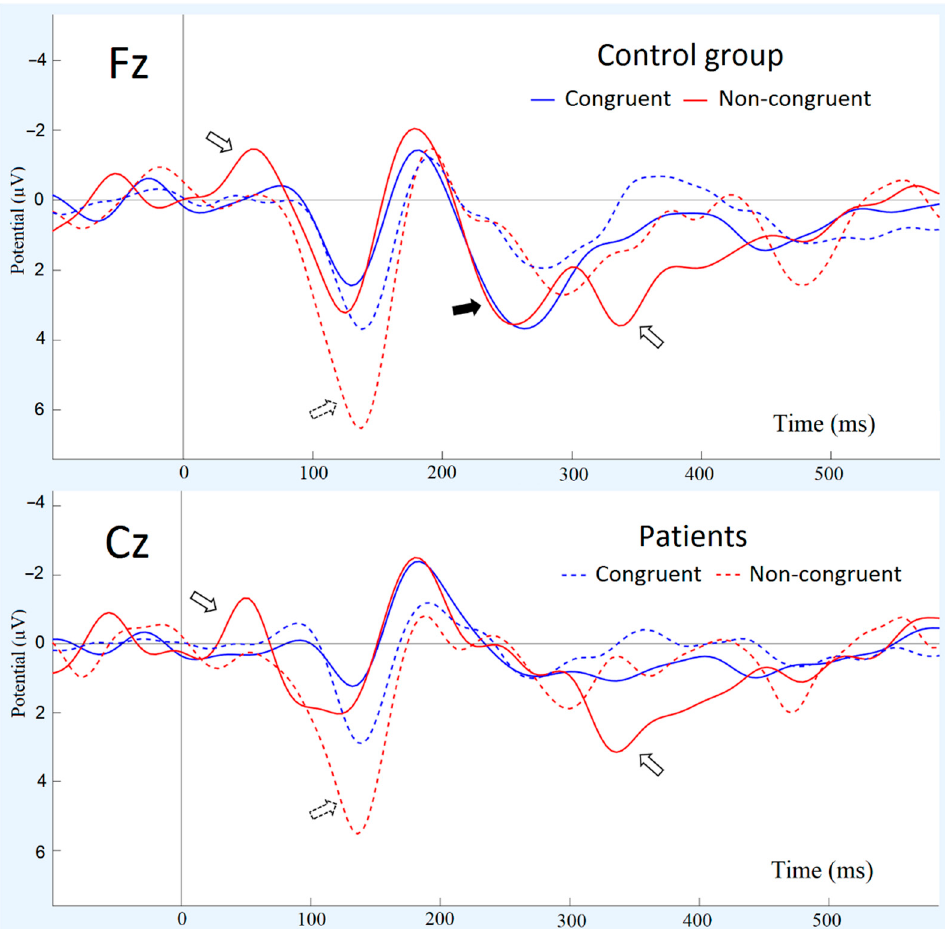
Figure 2. Event–related potential (ERPs) for congruent and non–congruent stimuli in two electrode sites (Fz, Cz) for two groups (patients with schizophrenia and healthy controls): Potential (µV). Arrows indicate significant group differences: black contour arrow means that healthy subjects had differences between congruent and non–congruent, but patients did not; black dotted arrow means that patients had differences between congruent and non–congruent stimuli and control group did not; black arrow means that there is a significant group difference in component’s amplitude but no differences between stimuli.